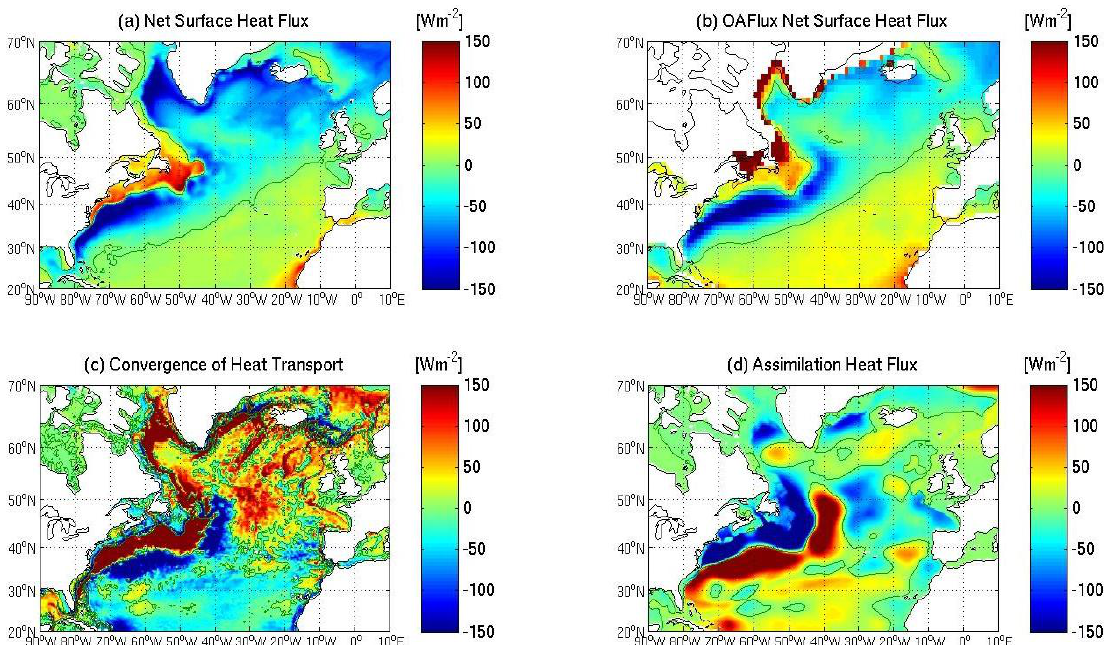
Fig. 6. Main components of the heat budget over the North Atlantic in UR025.3 for 1993–2009. (a) Net surface heat flux, (c) Heat transport convergence, (d) Assimilation increments equivalent heat flux. (b) provides a comparison from an independent surface heat flux product Figure 5 Main components of the heat budget over the N Atlantic in UR025.3 for 1993-2009. a) Net OAFlux (from Wong et al.,